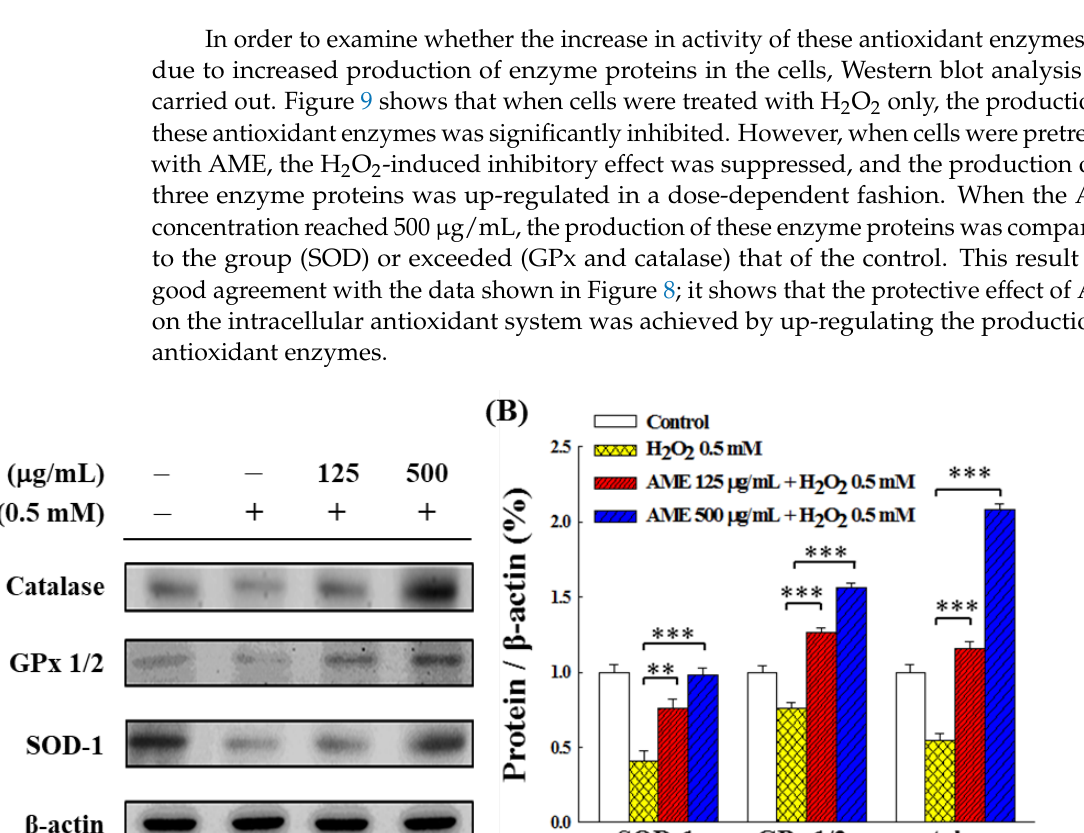
Figure 10. Effect of AME pretreatment on the ROS generation in H 2 O 2 -stimulated PC12 cells. ( A ) The intracellular ROS levels indicated by DCF-DA fluorescence intensity. ( B ) Fluorescent quantita- tion. This experiment was repeated three times. The significance of the difference in data compared to the vehicle (group 0) is labeled as *** p < 0.001. 3.7. Effect of AME Pretreatment on Inflammatory Responses Oxidative stress can stimulate the inflammatory response. Figure 11 shows that the H 2 O 2 induction substantially increased the expression of pro-inflammatory cytokines and mediators (e.g., IL-1 β, TNF- α, COX-2 and iNOS) and phosphorylation of NF- κ B in PC12 cells. Pretreatment with AME, even at a low AME dose (125 μ g/mL), significantly reduced the expression of IL- 1β, TNF - α and COX -2. However, effectively down-regulating the iNOS expression and NF- κ B phosphorylation required AME concentration at 500 μ g/mL, indicating that AME pretreatment was less sensitive in regulating the iNOS expression and NF- κ B phosphorylation.